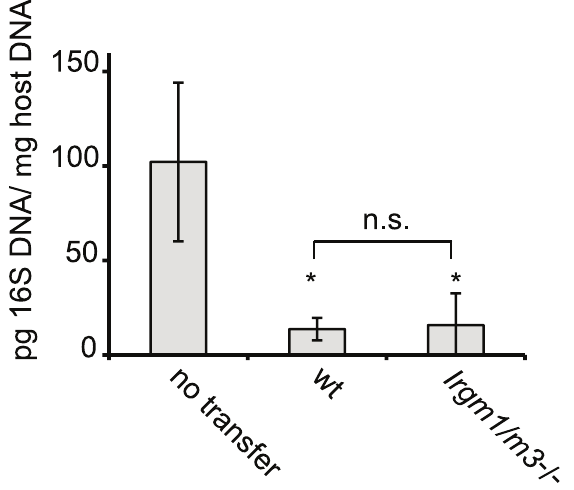
Figures 2. C.trachomatis -specific CD4 + T cells lacking Irgm1 and Irgm3 convey protection to an intrauterine infection with C. trachomatis. Th1-skewed wildtype NR1 cells or Irgm1/m3 (-/-) NR1 cells were adoptively transferred into mice deficient for IFN c production ( Ifng -/- mice). The following day these mice were transcervically infected with 2 * 10 6 IFUs of C. trachomatis . Three days post-infection, uteri were taken from sacrificed mice and bacterial yield was quantified using qPCR. Data are representative of two independent experiments. Statistical significance relative to the no transfer group is indicated as *, p , 0.05. n.s. = not